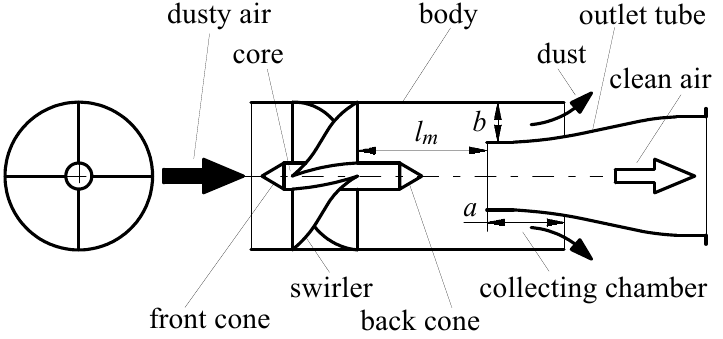
Figure 2. Main elements of axial flow cyclone: a —length of the collecting chamber, b —width of the collecting chamber, l m —separation length of the cyclone (distance of the swirler from the separation chamber).